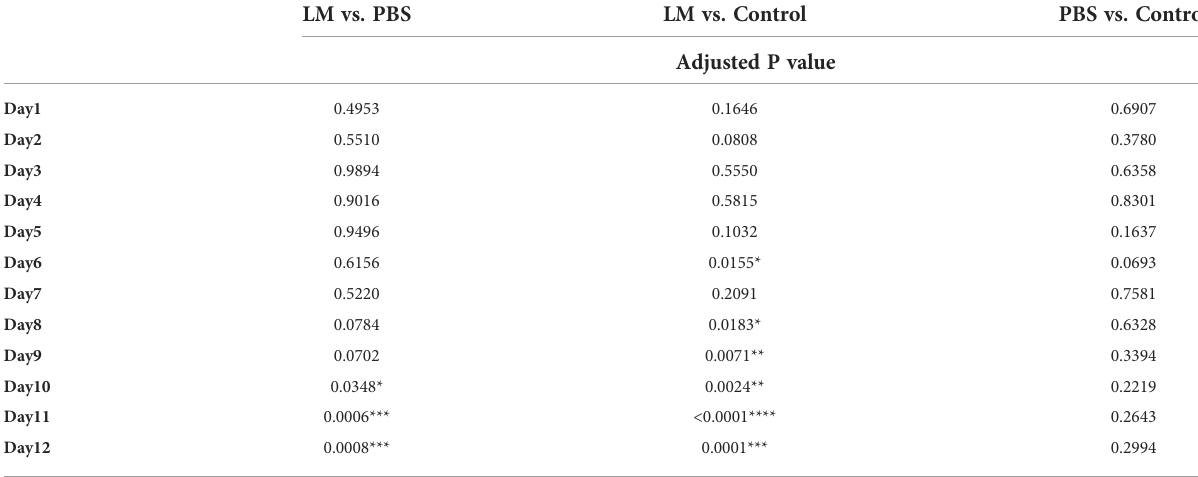
TABLE 2 The statistical results of post-hoc analysis for the volumes change ratio of primary tumor across days. LM vs.